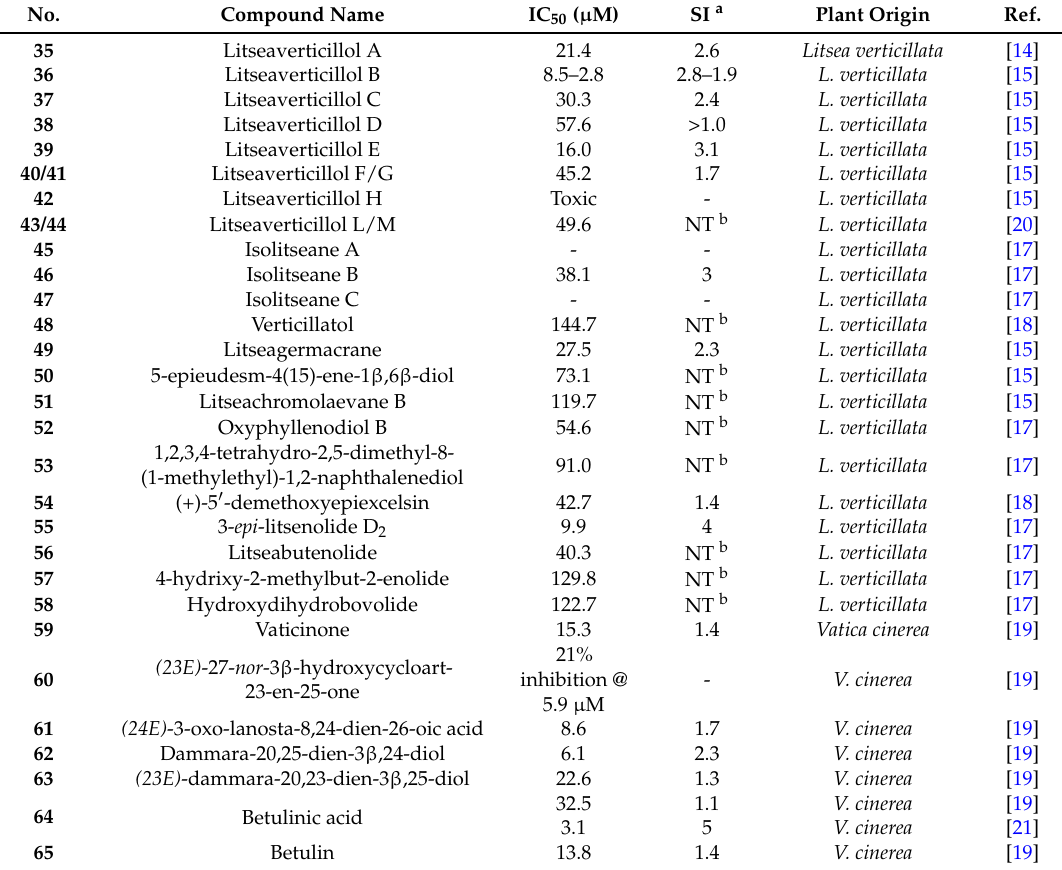
Table 2. The anti-HIV activity of compounds 35 – 76 .